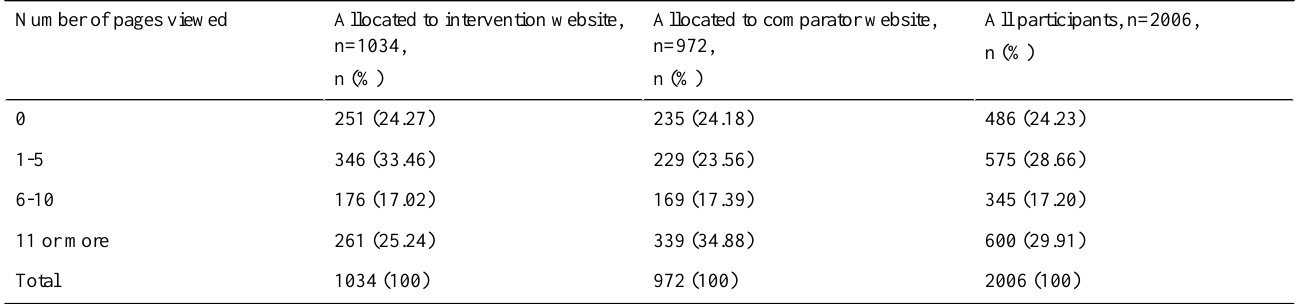
Table 4. Number of pages of intervention or comparator websites viewed.